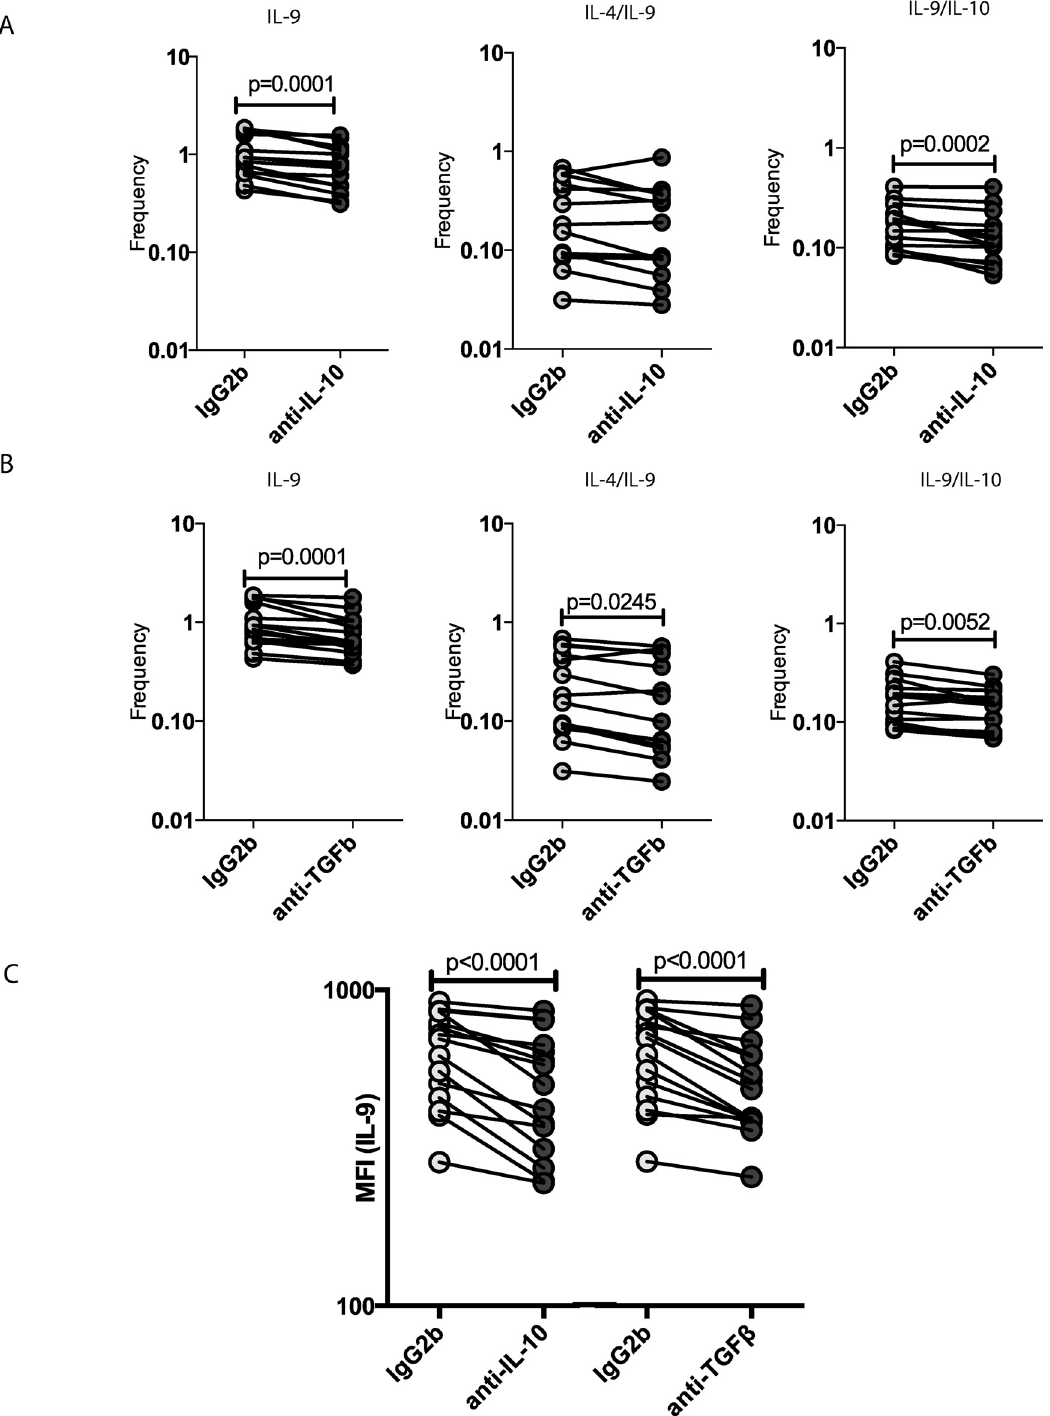
Fig 3. IL-10 and TGF β mediate the expansion of mono- and dual-functional Th9 cells in Strongyloides infections. (A) IL-10 neutralization (with anti-IL- 10 antibody) significantly diminishes the frequencies of mono- functional or dual-functional CD4 + Th9 cells following stimulation with NIE in a subset of INF individuals (n = 15). (B) TGF β neutralization (with anti-TGF β antibody) significantly diminishes the frequencies of mono- functional or dual-functional CD4 + Th9 cells following stimulation with NIE in a subset of INF individuals (n = 15). (C) Both IL-10 and TGF β neutralization significantly reduce the MFI of IL-9 expression on CD4 + T cells following stimulation with NIE in a subset of INF individuals (n = 15). Antigen-stimulated frequencies are shown as net frequencies with the baseline levels subtracted. Each line represents a single individual. P values were calculated using the Wilcoxon signed rank test.